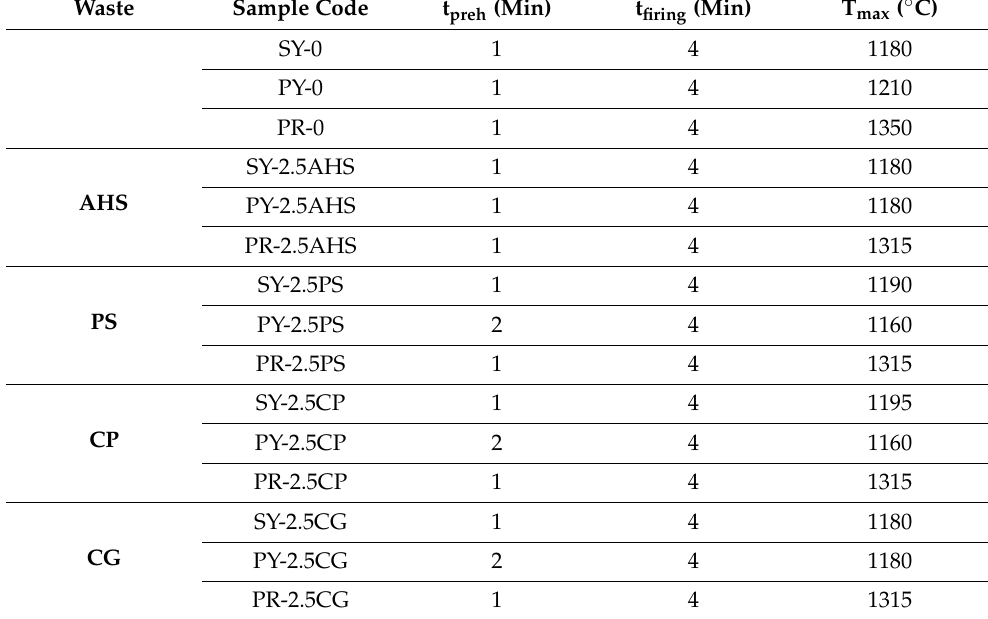
Table 2. Mixtures and firing conditions (t preh = preheating time in the kiln inlet; t firing = firing time in the middle of the kiln; T max = maximum temperature reached in the middle of the kiln).